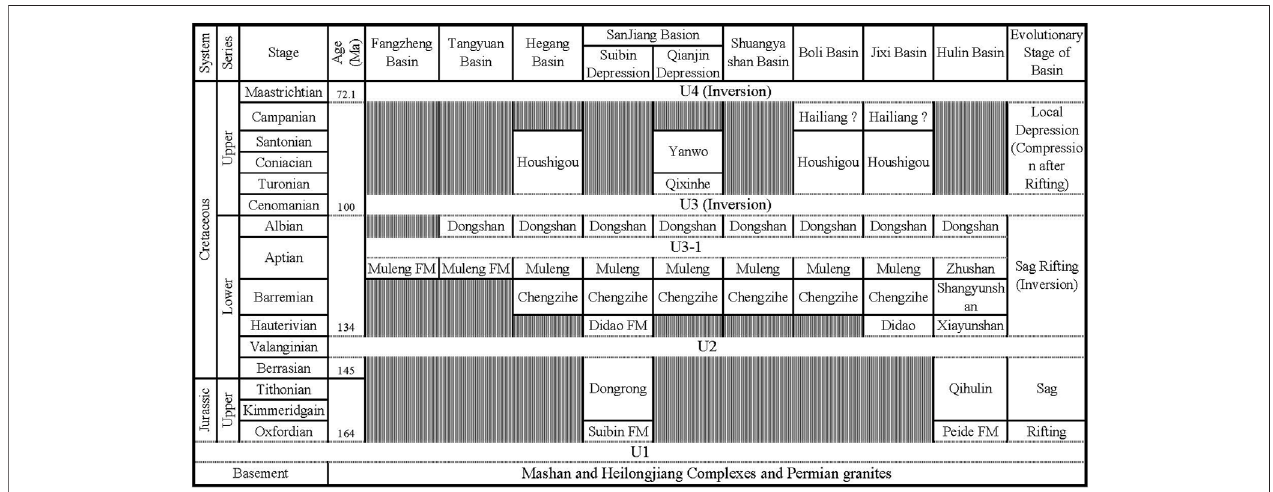
FIGURE 2 | Stratigraphic classi fi cation and comparison of the primary basins in the EHLJ (modi fi ed after Sha and Galina, 2009; Zhang et al., 2015; Zhao et al., 2017; He et al., 2009). Chronostratigraphic correlations are from the 2013 Geological Time Scale (Walker et al., 2013). Note: U1 – U4 are unconformities; U1 = Jurassic/ basement; U2 = Cretaceous/Jurassic; U3 = Upper Cretaceous/Lower Cretaceous; U3-1 = Dongshan Fm/Muleng Fm; U4 = Paleogene/Cretaceous.